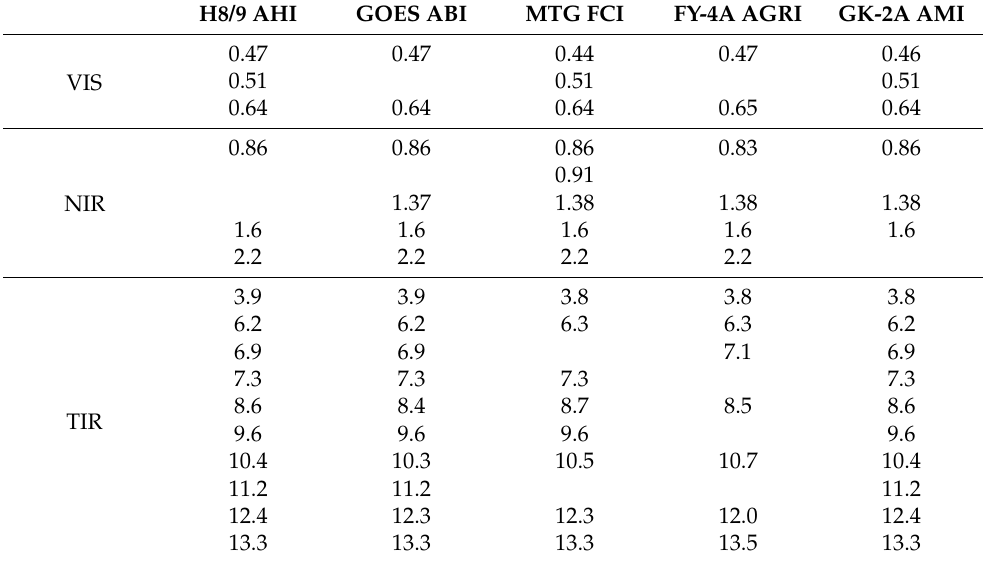
Table 1. Band center wavelength specifications for major third-generation geostationary meteoro- logical satellite optical imagers (in µ m). AHI, Advanced Himawari Imager; GOES, Geostationary Operational Environmental Satellites; ABI, Advanced Baseline Imager; MTG, Meteosat Third Genera- tion; FCI, Flexible Combined Imager; FY-4A, Fengyun-4A; AGRI, Advanced Geostationary